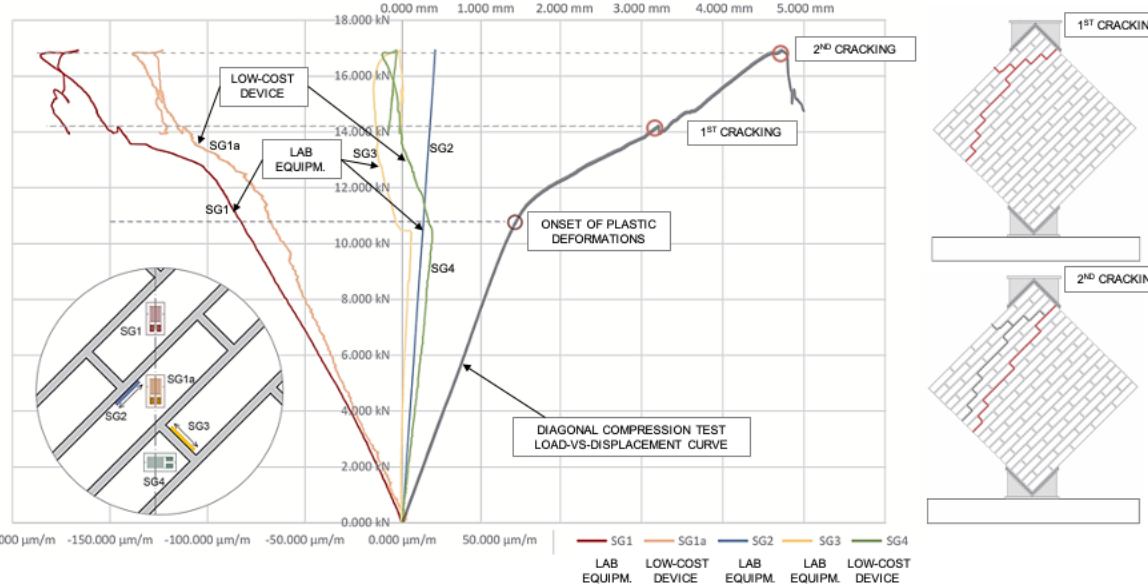
Figure 8: Results of the diagonal compression test of a reduced-scale masonry panel